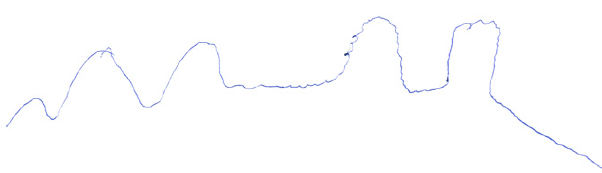
Figure 3. MA’s depiction of his perception upon presentation of repetitions of the illusion inducing sequence. The patient depicted a repeating smooth contour, consistent with the judgments he made on multiple choice